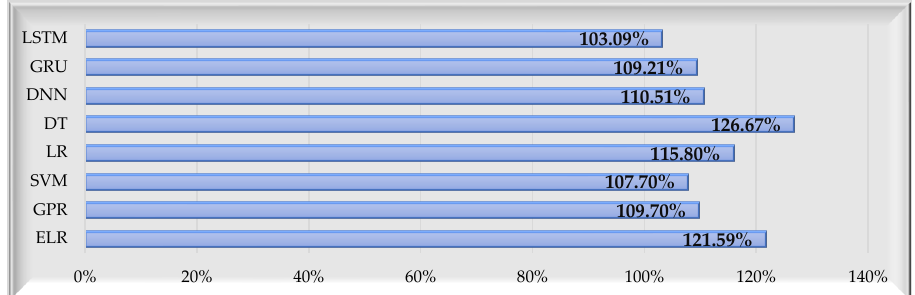
Figure 16. Average accuracy comparison of advanced learning algorithms.